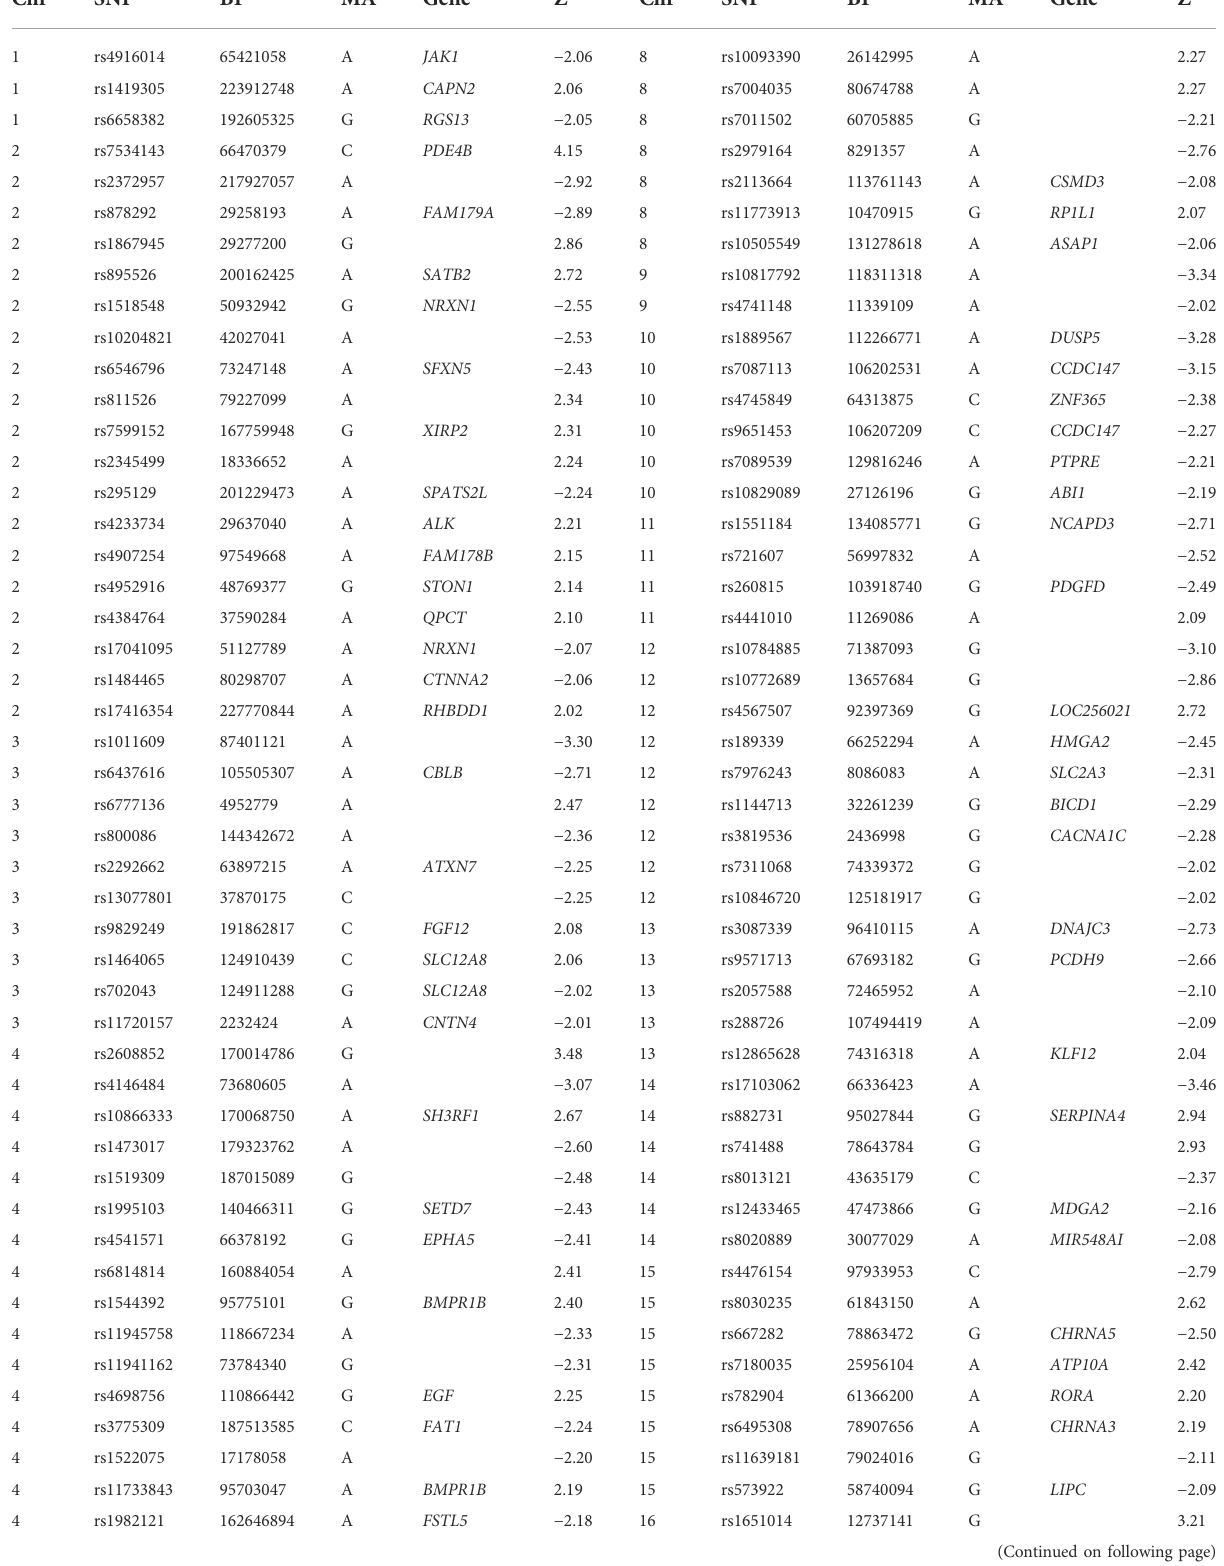
TABLE 2 High-ranking SNPs with |Z| > 2 ( n =